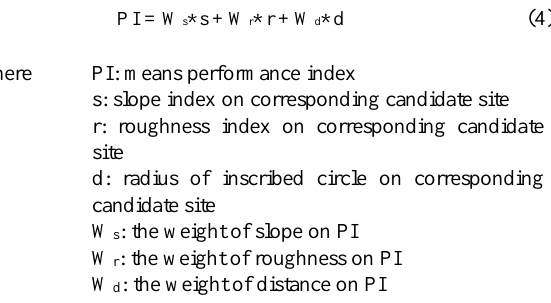
Figure 2. Hazard presented in roughness map On the basis of the generated slope and roughness map, we could extract the hazard through the image segmentation method. The threshold for segmenting is 15° and 0.3 on slope index and roughness index